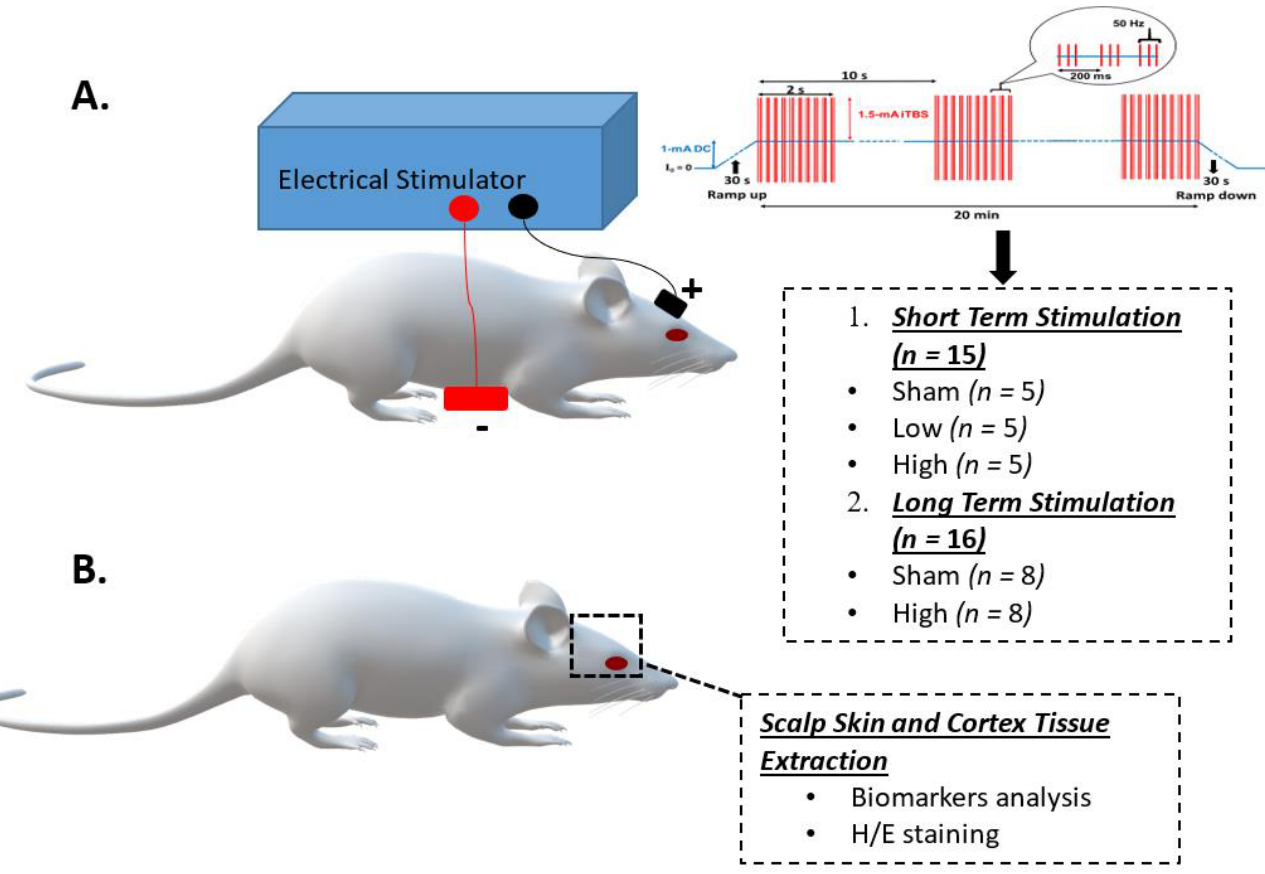
Figure 9. Schematic representation of ( A ) electrical stimulation of rat primary cortex; ( B ) scalp skin and cortex tissue extraction after short- and long-term stimulation interventions.